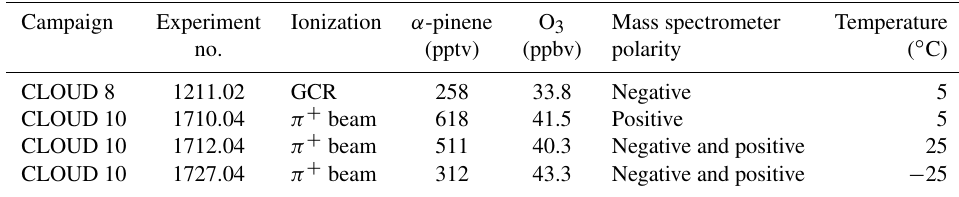
Table 1. Experiments performed at the CLOUD chamber.